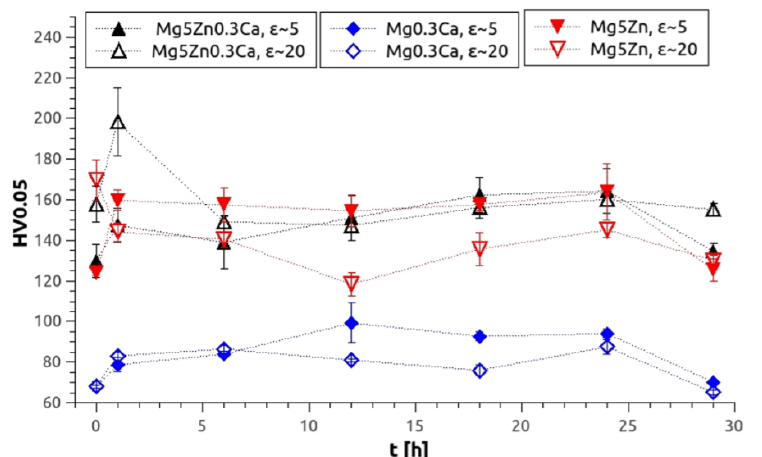
Figure 9. Microhardness after heat treatments at the peak temperature of 100 °C with varying annealing times up to 29 h for Mg5Zn0.3Ca (black), Mg5Zn (red) and Mg0.3Ca (blue) processed at different strains.